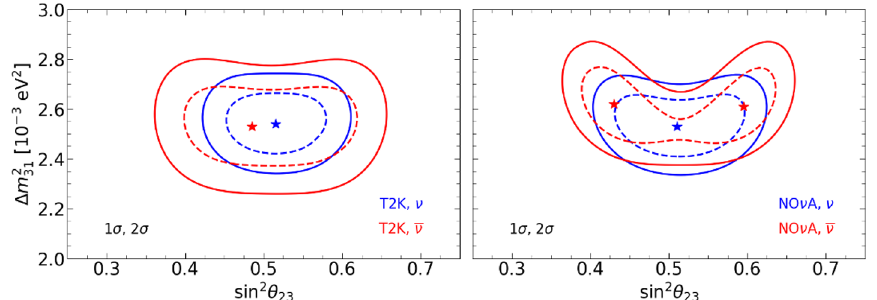
plane (sin 2 (cid:18) 23 {(cid:1) m 2 31 31